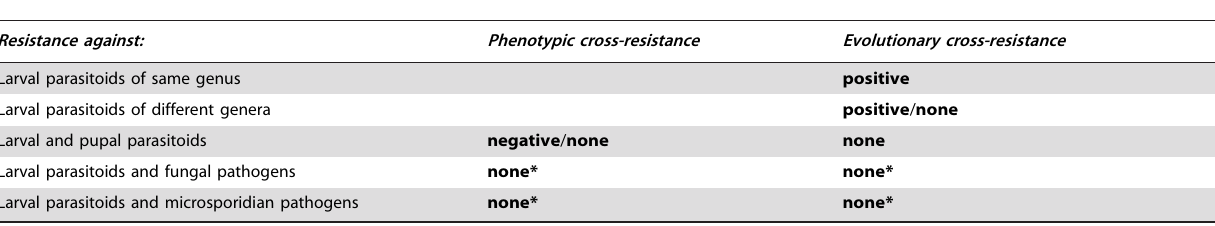
Table 1. Cross-resistance in Drosophila melanogaster